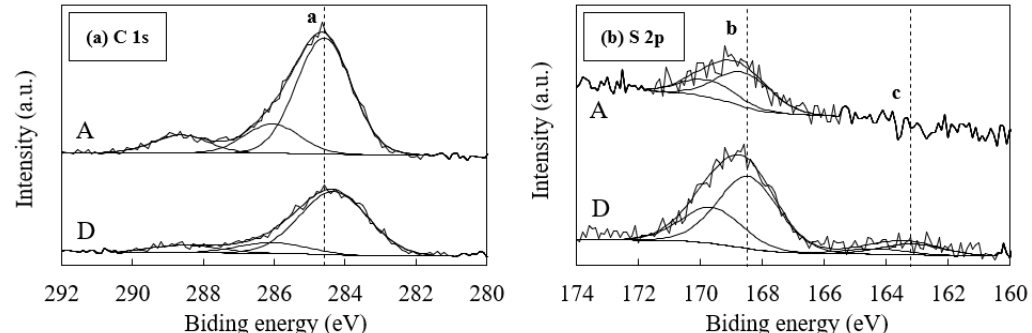
Figure 8. X-ray photoelectron (XP)-spectra of ( a ) C 1s and ( b ) S 2p for samples A and D. The binding energy is corrected using E B [C 1s A ] from hydrocarbon = 284.6 eV. Peak a of C 1s corresponds to 284.6 eV, peak b of S 2p 3/2 corresponds to 168.5 eV, and peak c of S 2p 3/2 corresponds to 163.2 eV.